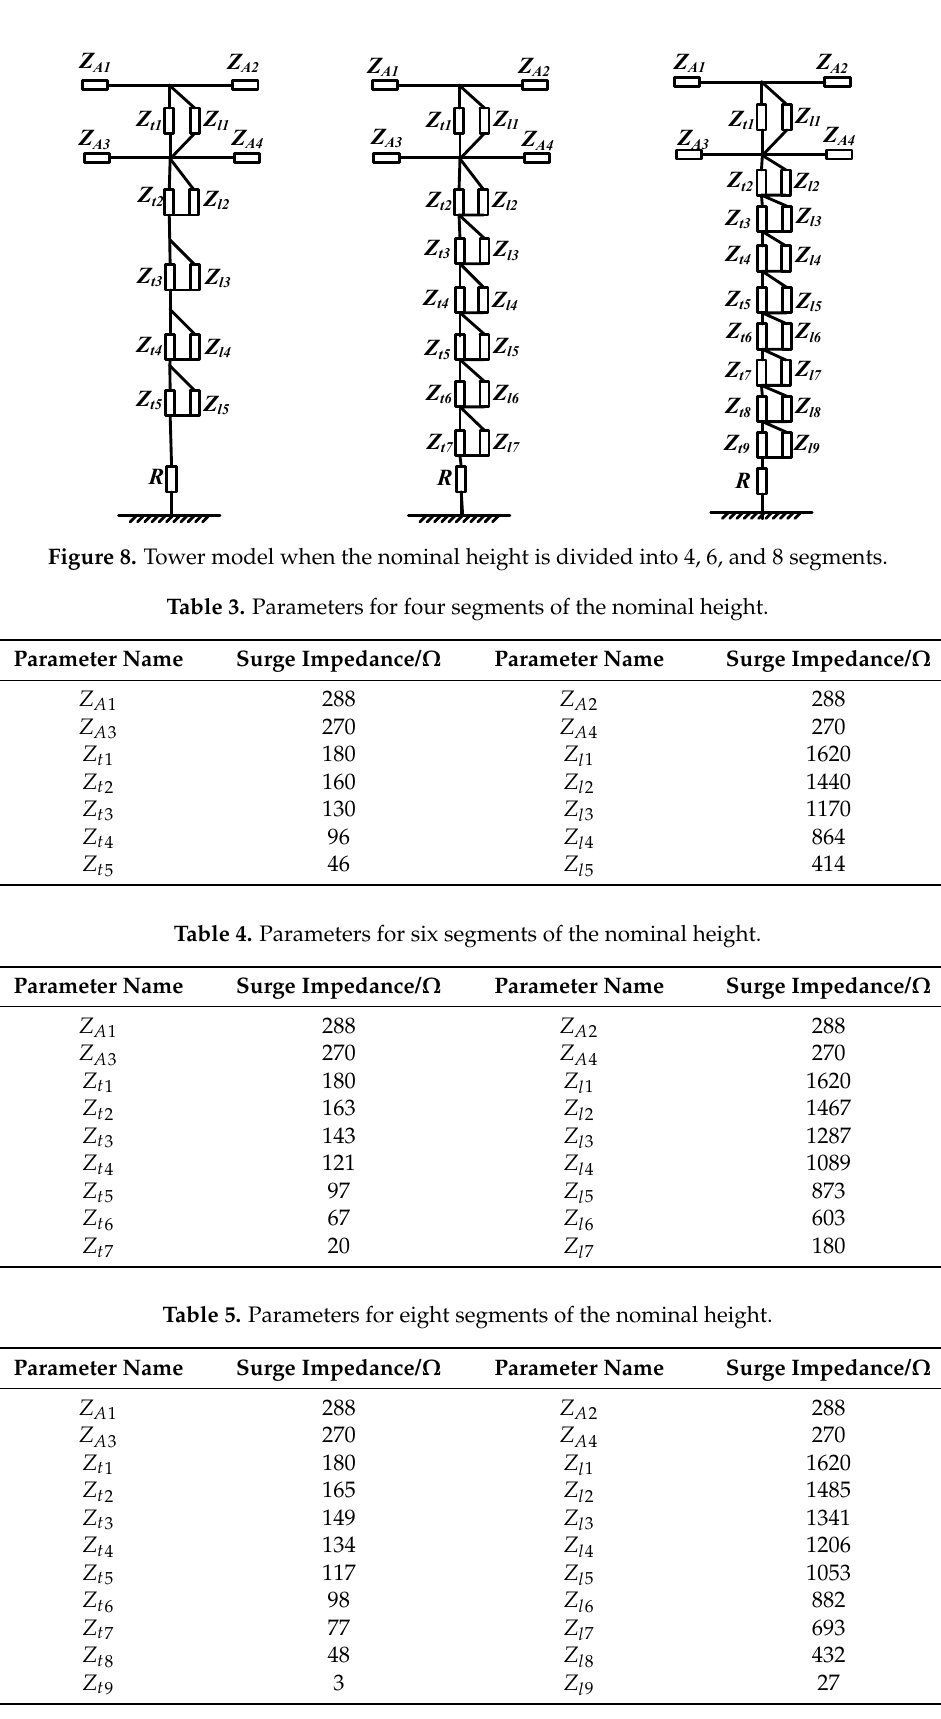
Table 5. Parameters for eight segments of the nominal height.